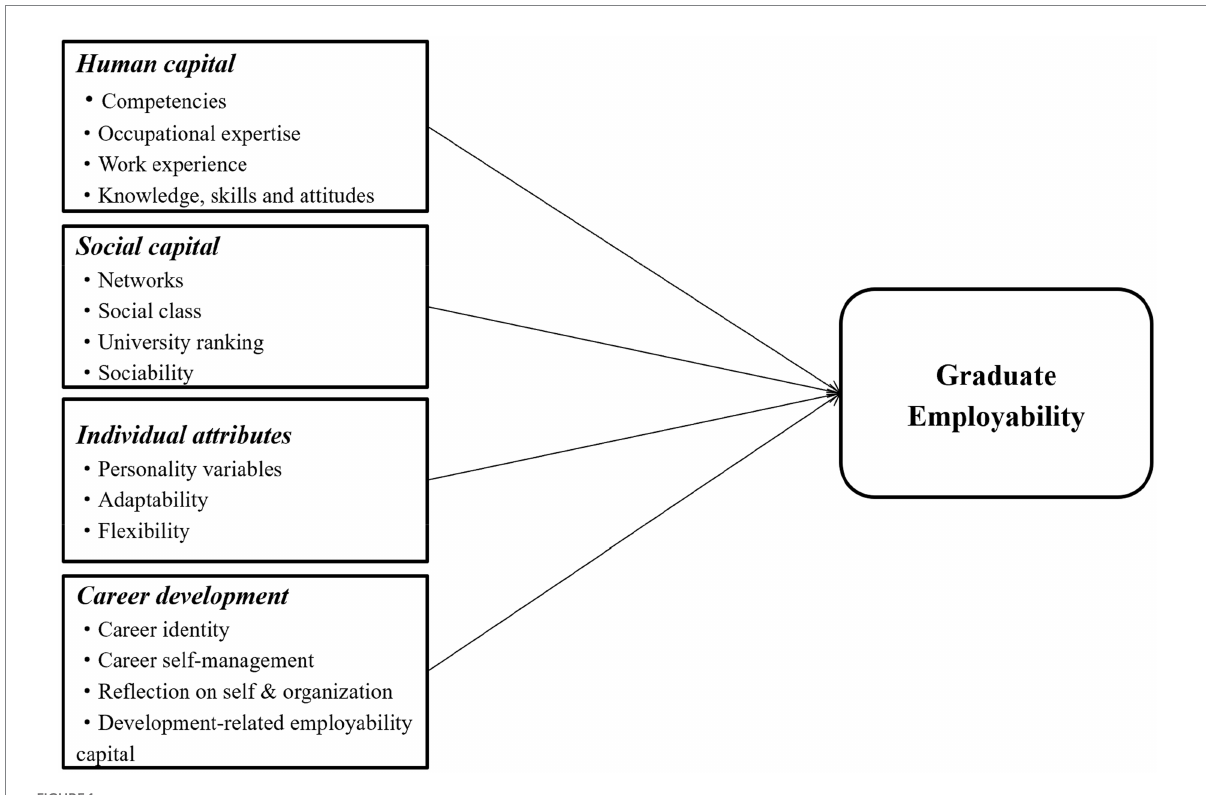
FIGURE 1 Connotation of employability